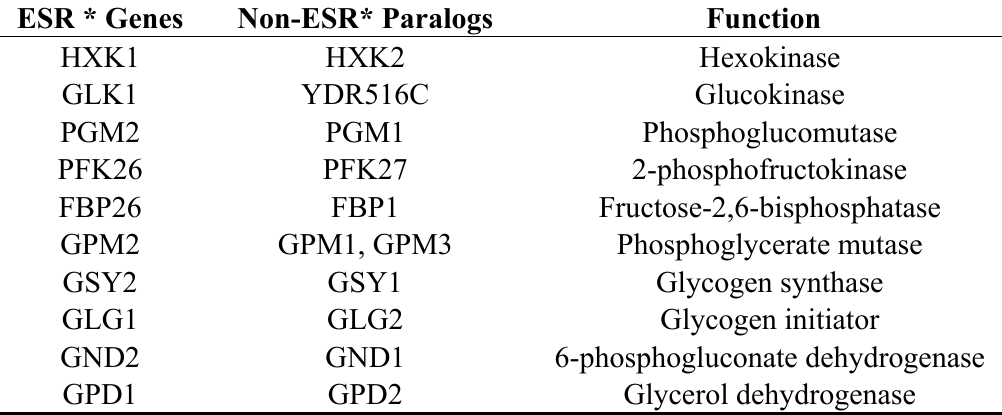
Table 1. Differentially regulated protein paralogs (adapted from